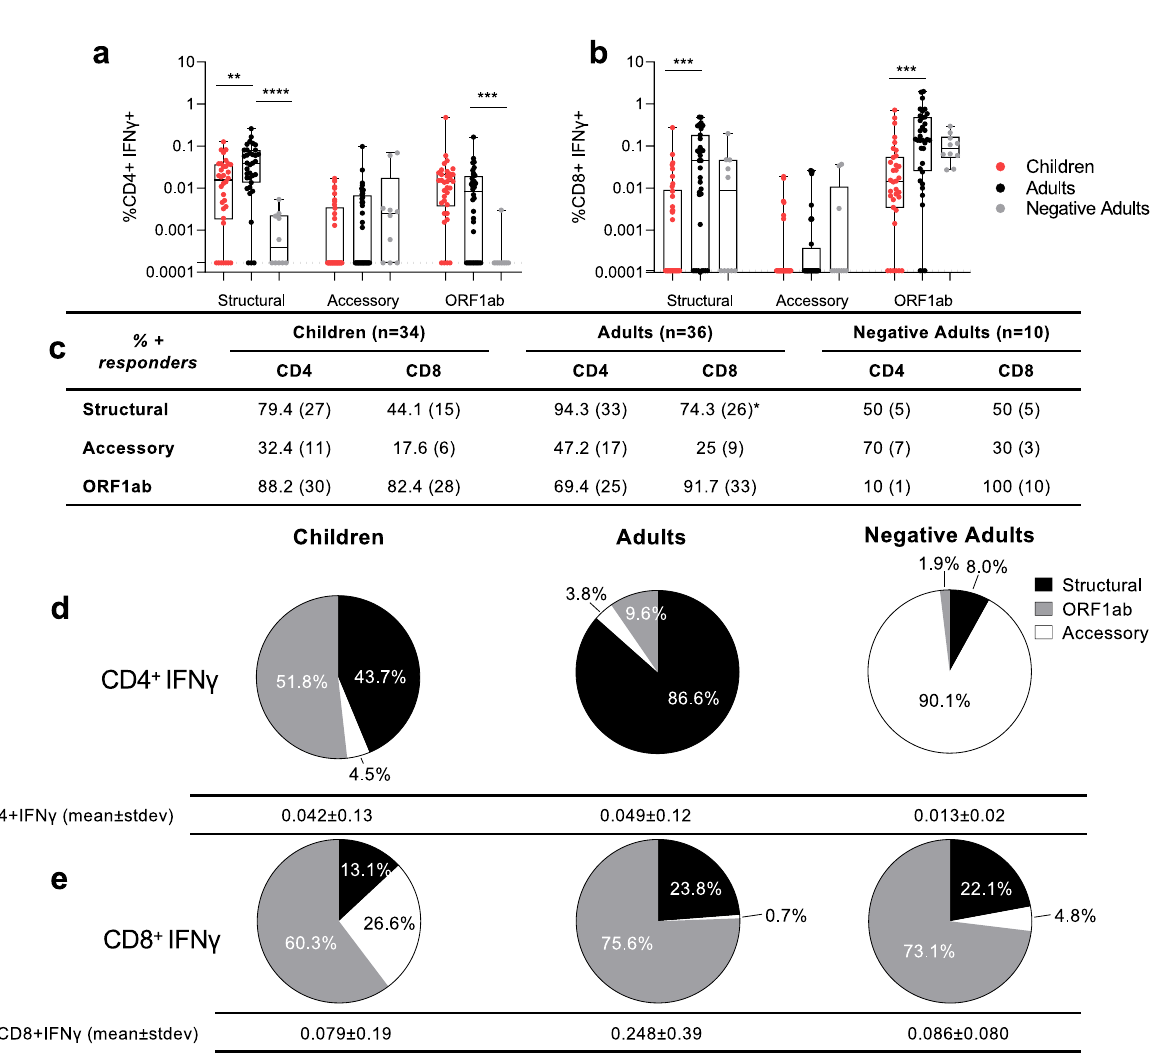
Fig. 2 Speci fi city of T cell responses in adults and children. The SARS-CoV-2 CD4 + ( a ) or CD8 + ( b ) T cell responses of COVID-19 children ( n = 34), adults ( n = 36) (mean±stdev: 42±44, range 1 – 180 days) and negative adults ( n = 10). Data are displayed as individual responses to each peptide pool with IFN γ production to paired DMSO subtracted, with box and whiskers plots displaying the median, upper and lower quartiles, minimum and maximum values. The dotted line represents the lower limit of detection, determined as the smallest calculated value above the DMSO background response (IFN γ of CD4 + = 0.00017%, IFN γ of CD8 + = 0.00011%). a , b Comparisons between groups were performed using two-sided Mann – Whitney test statistical differences are indicated by * p <0.05, ** p <0.01, *** p <0.001. Values above the limit are used to classify participants as responders and presented as a percentage with the numbers of responders in brackets ( c ). Differences between children ( n = 34) and adults ( n = 36) from all time points (1 to 180 days post symptom onset) were determined by Fisher ’ s exact test and displayed in the adults column where * p <0.05. Pie charts show the proportion of total IFN γ + CD4 + ( d ) and CD8 + ( e ) SARS-CoV-2 responses with DMSO subtracted in children ( n = 34), adults ( n = 36) and negative adults ( n = 10) (from a , b ). Values below the limit of detection assigned the value of 0. ( a ) ** p = 0.0065, **** p <0.0001, *** p = 0.0008, ( b ) *** p = 0.0003, The difference in magnitude of T cell responses with age and exhaustion (by PD-1 expression) between infected adults and time indicates functional differences in T cell recruitment and children at either acute or memory responses (Fig. 4). differentiation, therefore we assessed cytokine polyfunctionality The fold change of response magnitude for paired acute and memory phenotypes. Cytokine polyfunctionality is responses (< 14 days) to memory time-points (> 14 days) (Fig. 5c, associated with increased protection from infection for multiple viruses 36,37 , and associated with cellular division and terminal differentiation 38 . Whilst differentiation of T cell memory phenotypes occurs early during infection and can re fl ect the extent of in fl ammation 39 , impacting recall capacity long-term 40 to infected tissues 41 . Cytokine polyfunctionality of structure-speci fi c T cells (Fig- ure 6a, b) was comparable between adults and children at acute (< 14 days), convalescent (15 – 60 days), or memory (61 – 180 days) time points (Fig. 6c), therefore on per-cell basis adults and (Figure 5f, I, j), excluding acute CD8 + T cell responses children had comparable cytokine responses. The phenotype of (Figure 5g).